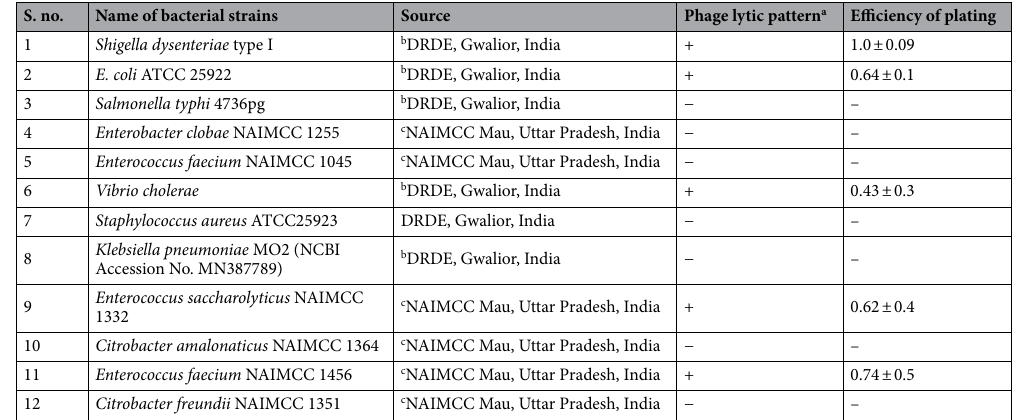
Table 1. Host range and efficiency of plating (EOP) of Shigella virus 2019SD1. a Results recorded as + Sensitive; − No infection. b In-house collection from previous study. c National Agriculturally Important Microbial Culture Collection